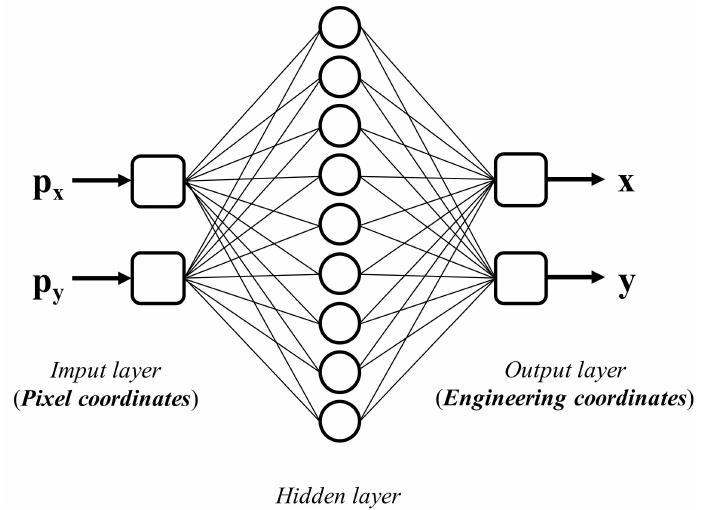
Figure 4. The structure of the artificial neural network (ANN) used to convert the pixel coordinates to the engineering